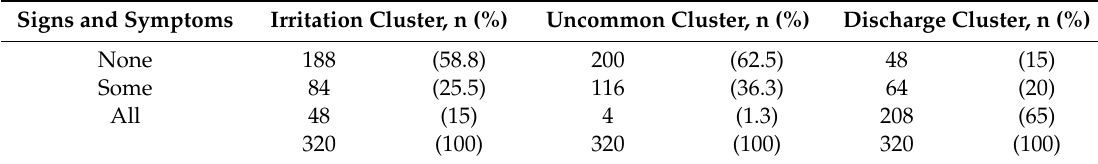
Table 4. Presence of signs and symptoms (SS) among clusters of